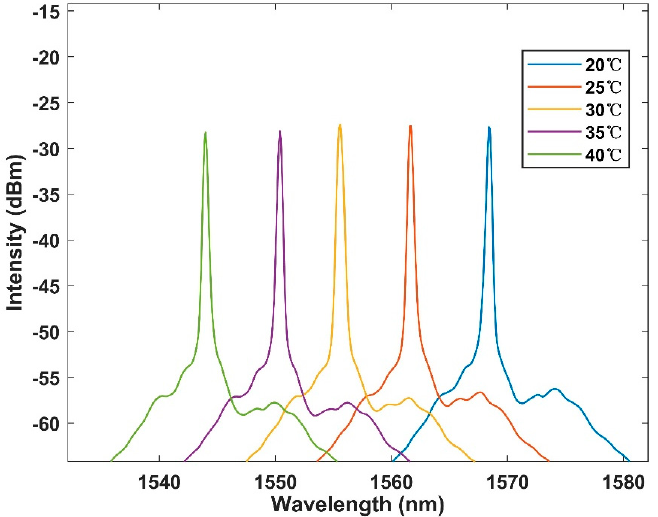
Figure 12. Different output spectra of the laser, varying with temperature (20 °C–40 °C; interval is 5 °C).